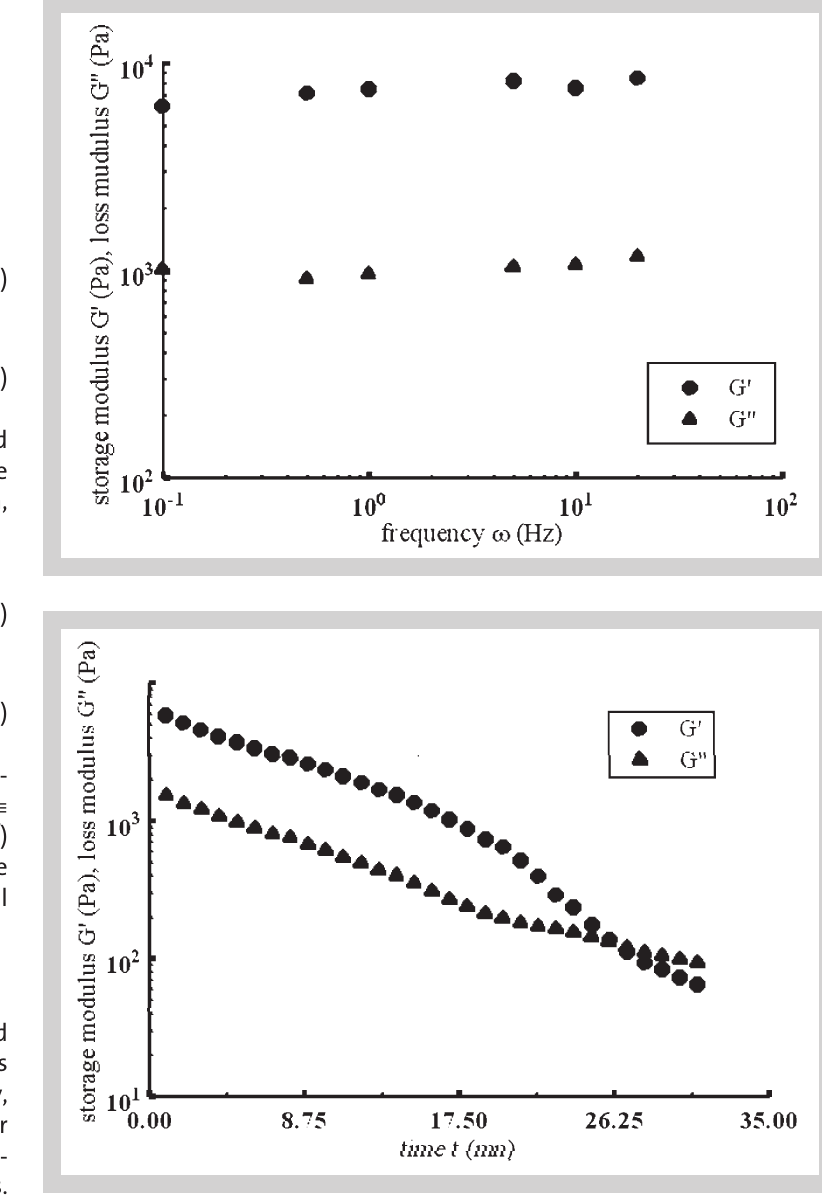
Figure 6 (above): The storage and loss moduli as a function of the frequency at a stress amplitude of 5 Pa (1440 kg/m3 mud sample). Figure 7 (below): The time-dependent behavior of the storage and loss moduli at a stress amplitude of 280 Pa and a frequency of 1 Hz (1490 kg/m3 mud